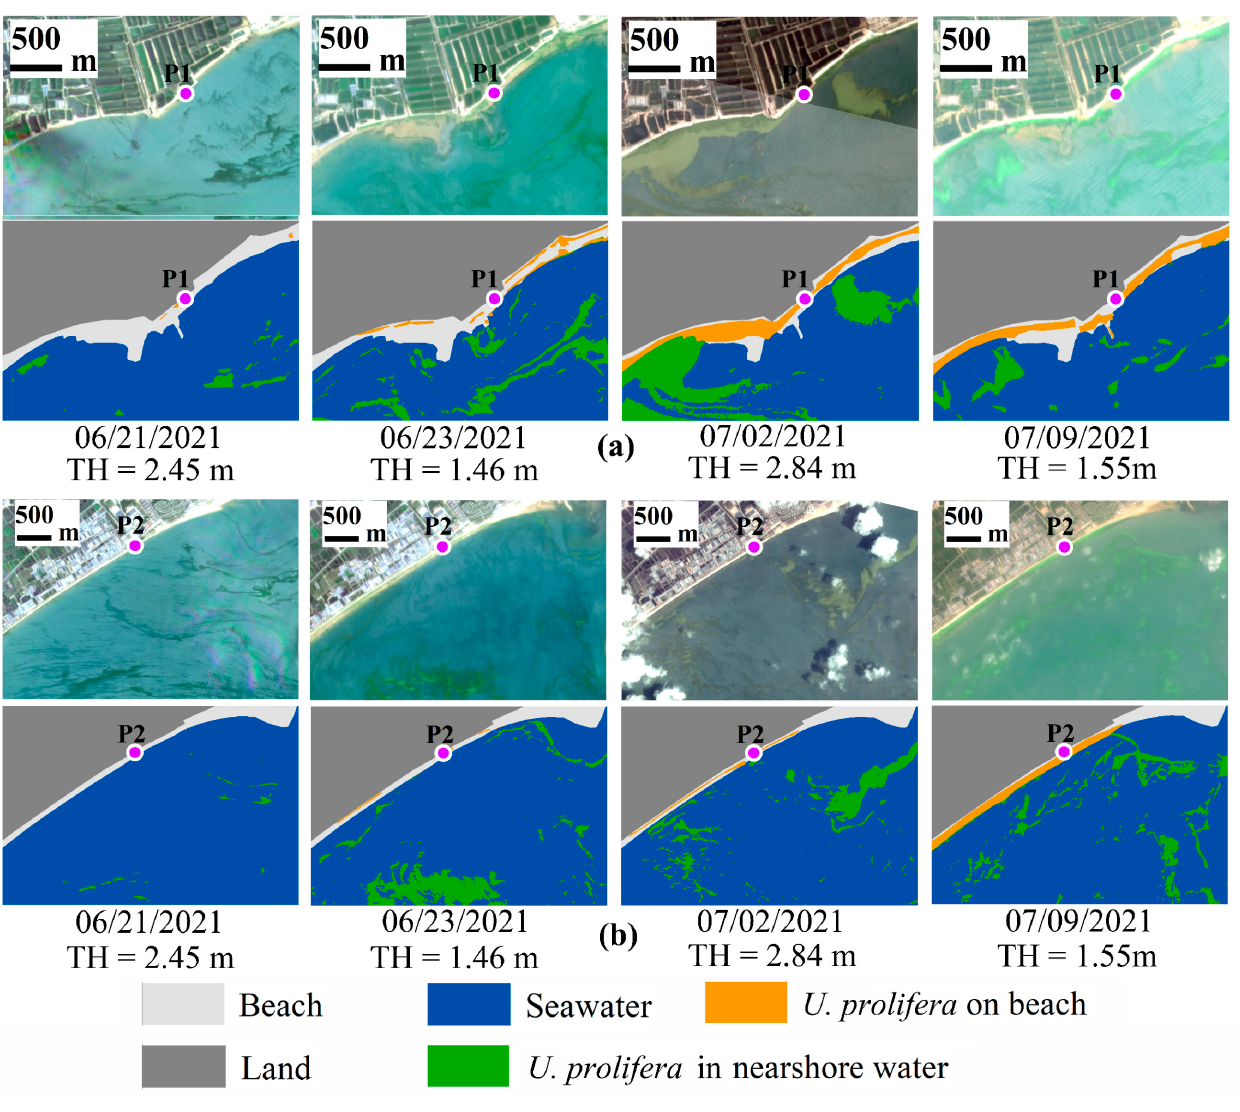
Figure 7. The extraction results of U. prolifera on the beach and in nearshore water in the P1 and P2 areas. ( a ) The spatiotemporal changes of U. prolifera on the beach and in nearshore water in the P1 area; ( b ) the spatiotemporal changes of U. prolifera on the beach and in nearshore water in the P2 area. The local tide height (TH) at the time of each image acquisition is marked on the figure.